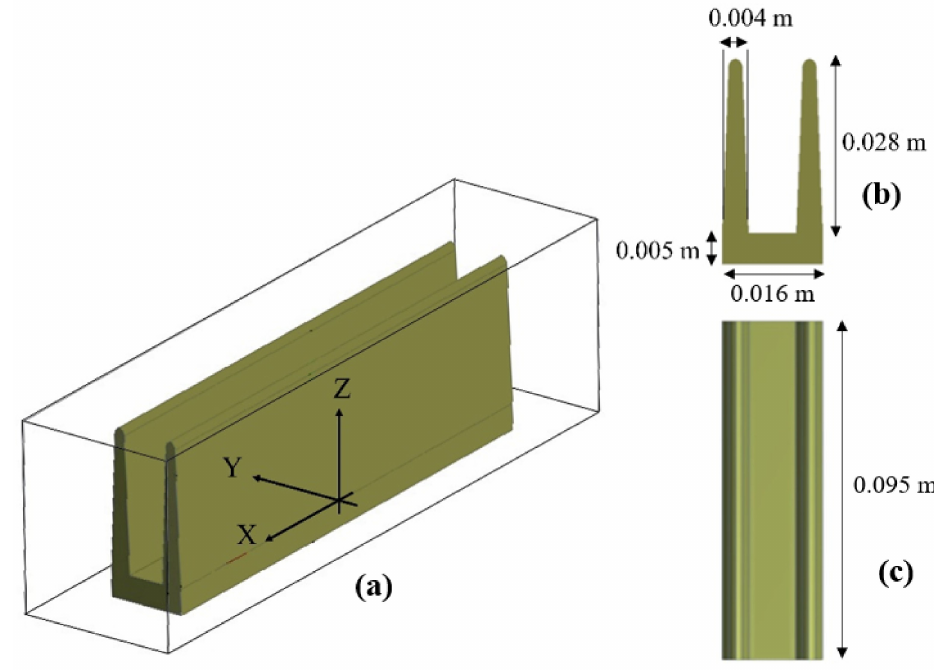
Figure 2. Physical model. ( a ) Isometric view, ( b ) side view, ( c ) top view. Mass, momentum, and energy conservation laws form the governing equations